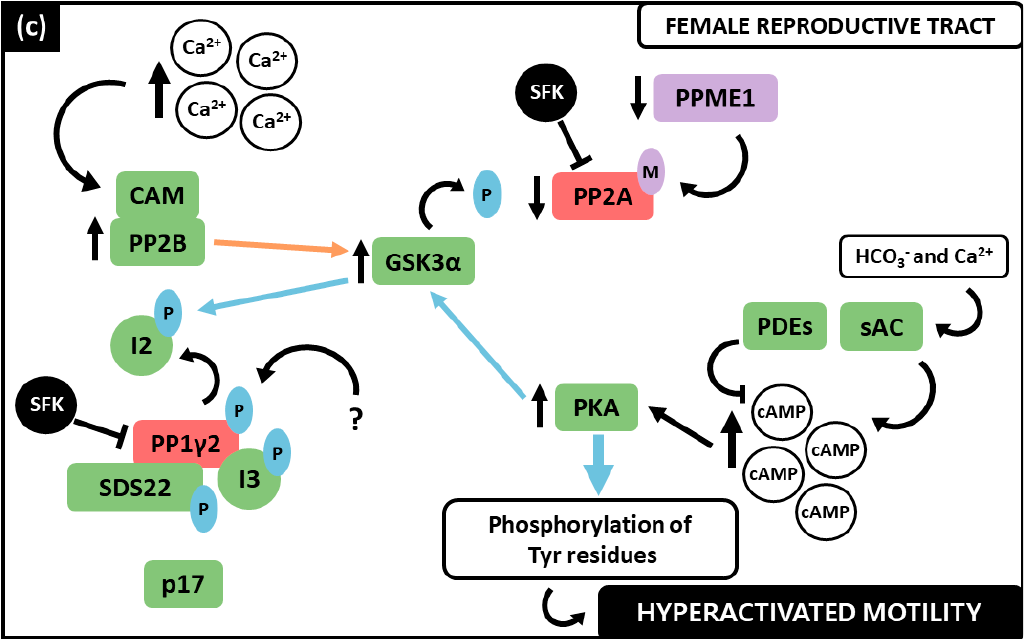
Figure 2. Interplay between the PPs, PP1 γ 2, PP2A and PP2B, and PKs, GSK3 and PKA, regarding sperm motility regulation. The color green represents catalytic activity, whereas red stands for enzymatic inactivity. Blue arrows define phosphorylation reactions, while orange represents dephosphorylation processes. ( a ) In caput immotile sperm, Ca 2+ increase promotes PP2B interaction with Ca 2+ -CAM complex that activates it. PP2B dephosphorylates GSK3 α increasing its activity. Phosphorylated PP2A also contributes to the phosphorylation of both GSK3 isoforms. GSK3 phosphorylates the I2 that disassociates from PP1 γ 2, rendering it active, solely in a complex with I3. The inhibitor SDS22 is bound to p17. PP1 γ 2 dephosphorylates GSK3 and Ser/Thr residues, resulting in immotile spermatozoa. PKA presents no significant catalytic activity. ( b ) In cauda epididymis, Ca 2+ concentration is lower, causing CAM dissociation from PP2B and its subsequent inactivity. PPME1 decreases allowing PP2A methylation and inactivity. Simultaneously, sAC is activated and produces cAMP, which in turn activates PKA. cAMP degradation is due to PDE activity. PKA phosphorylates PP1 γ 2 and GSK3 that decreases its activity and is no longer able to phosphorylate I2, which forms a complex with PP1 γ 2 and SDS22 that dissociates from p17. Lastly, PKA’s increased activity causes phosphorylation of Ser/Thr residues which are a requirement for activated motility acquisition. ( c ) The increase in Ca 2+ once again activates PP2B that dephosphorylates GSK3 α rendering it active and able to phosphorylate I2. Due to sAC activation by HCO 3- and Ca 2+ , cAMP further increases and stimulates PKA activity. PKA phosphorylates GSK3. PP1y2 is phosphorylated and in a complex with SDS22 and I3. SFK also contributes to decrease PP1y2 activity along with PP2A, that remains methylated. The increase in phosphorylation of Tyr residues contributes to achieve hyperactivated motility.